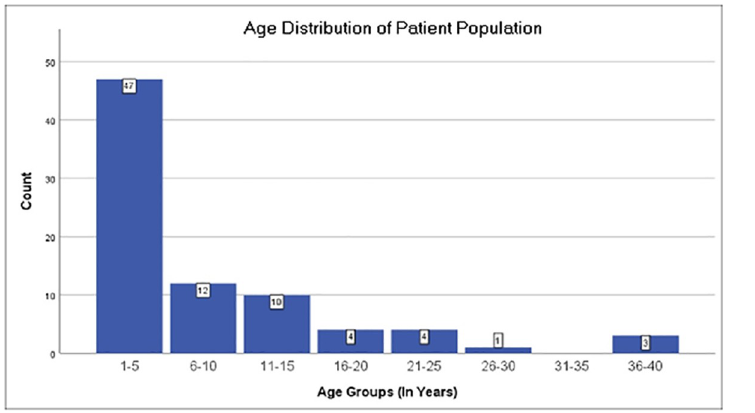
Fig 2. Age distribution of patient